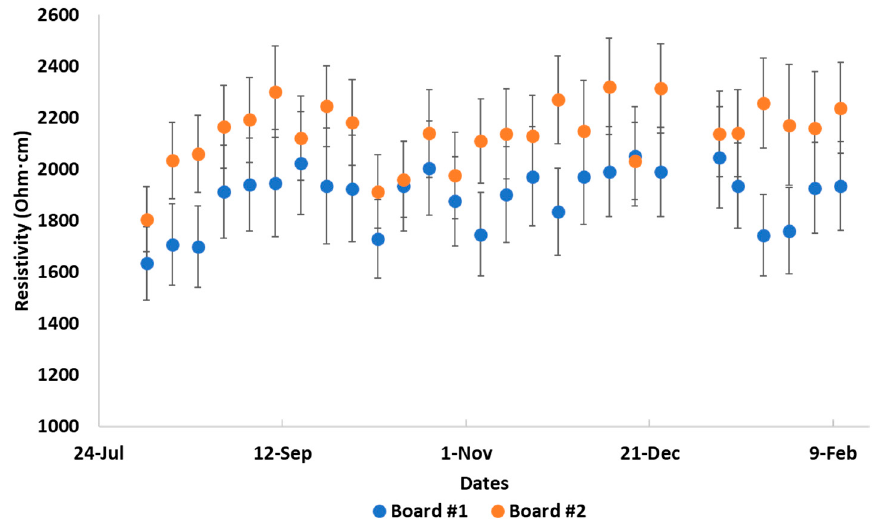
Figure 5. 0.014 wt% sample long term resistivity at standard atmosphere and temperature .